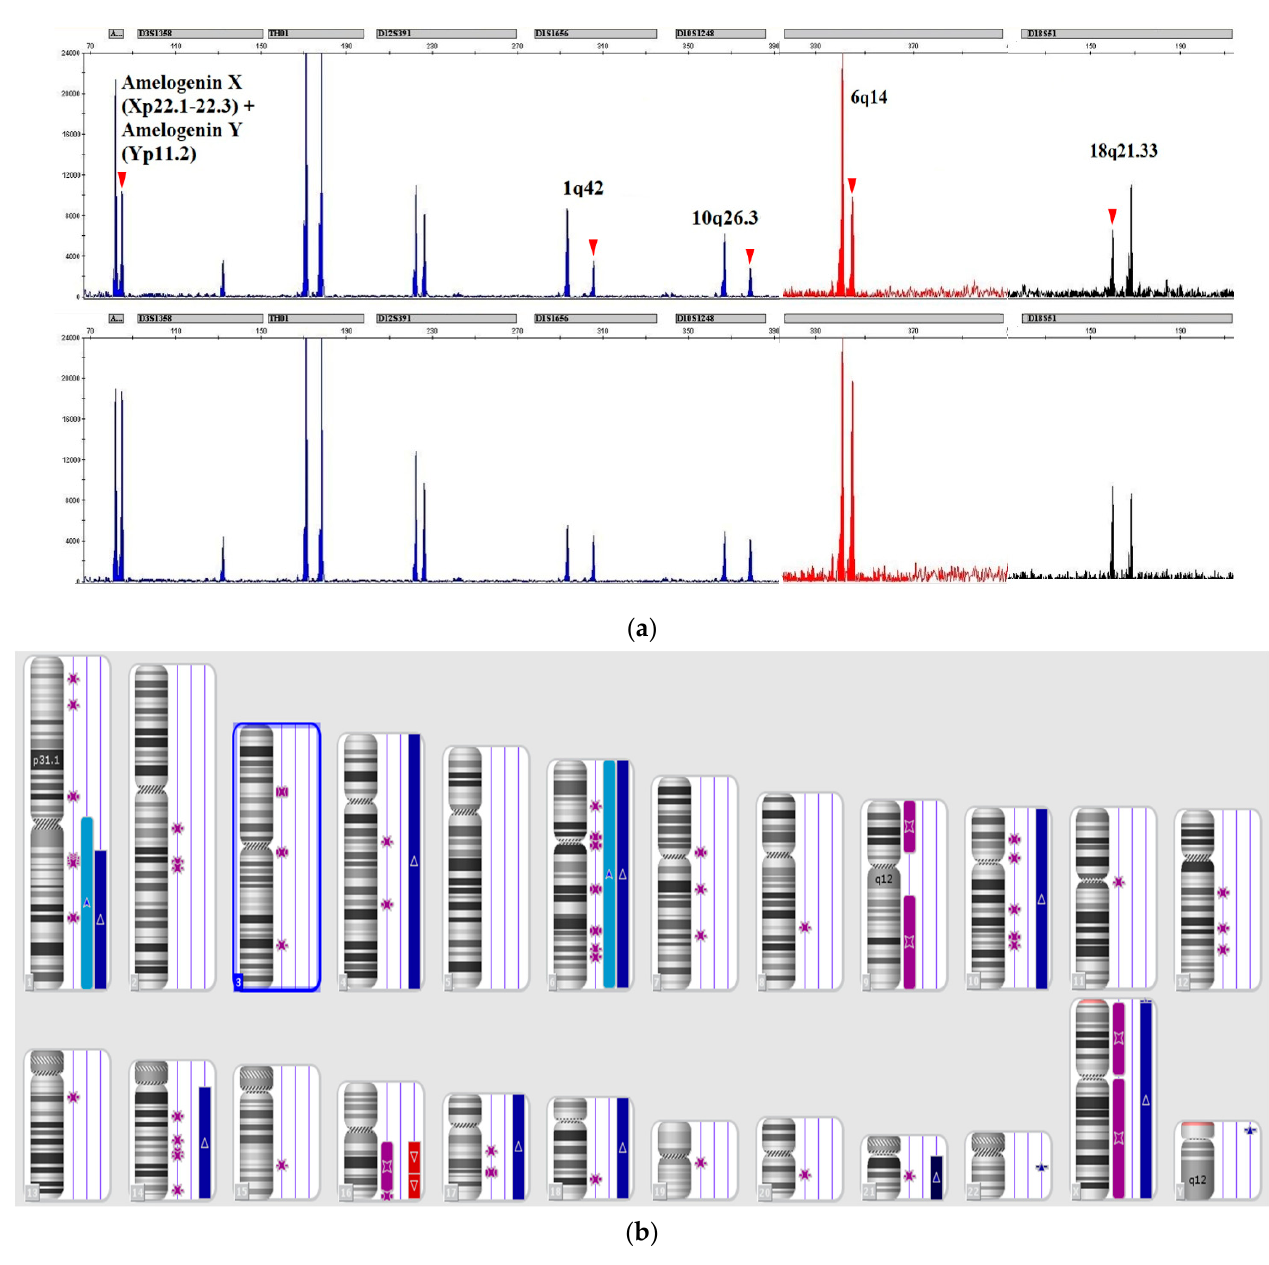
Figure 1. LOH patterns in STR profile of B-ALL patient 45 ( a , b ) molecular karyoview of CMA. The karyoview presents a diagram of all copy number variations (red bar for loss; blue bar for gain) and copy neutral LOH (purple bar). (LOH at 1q42, 10q26.3, 6q14, and 18q21.33 and disbalance at